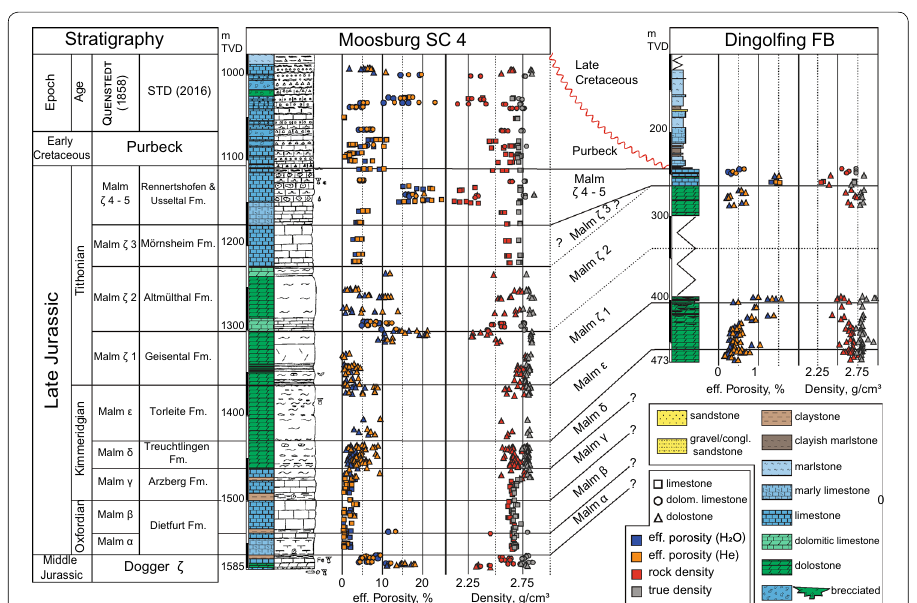
Fig. 3 Schematic correlation of the Upper Jurassic sections of the boreholes Moosburg SC 4 and Dingolfing FB. In addition to lithology, the porosity and density data measured during this research are shown. Each pair of values represents the location of a core sample in the corresponding depth (based on Meyer